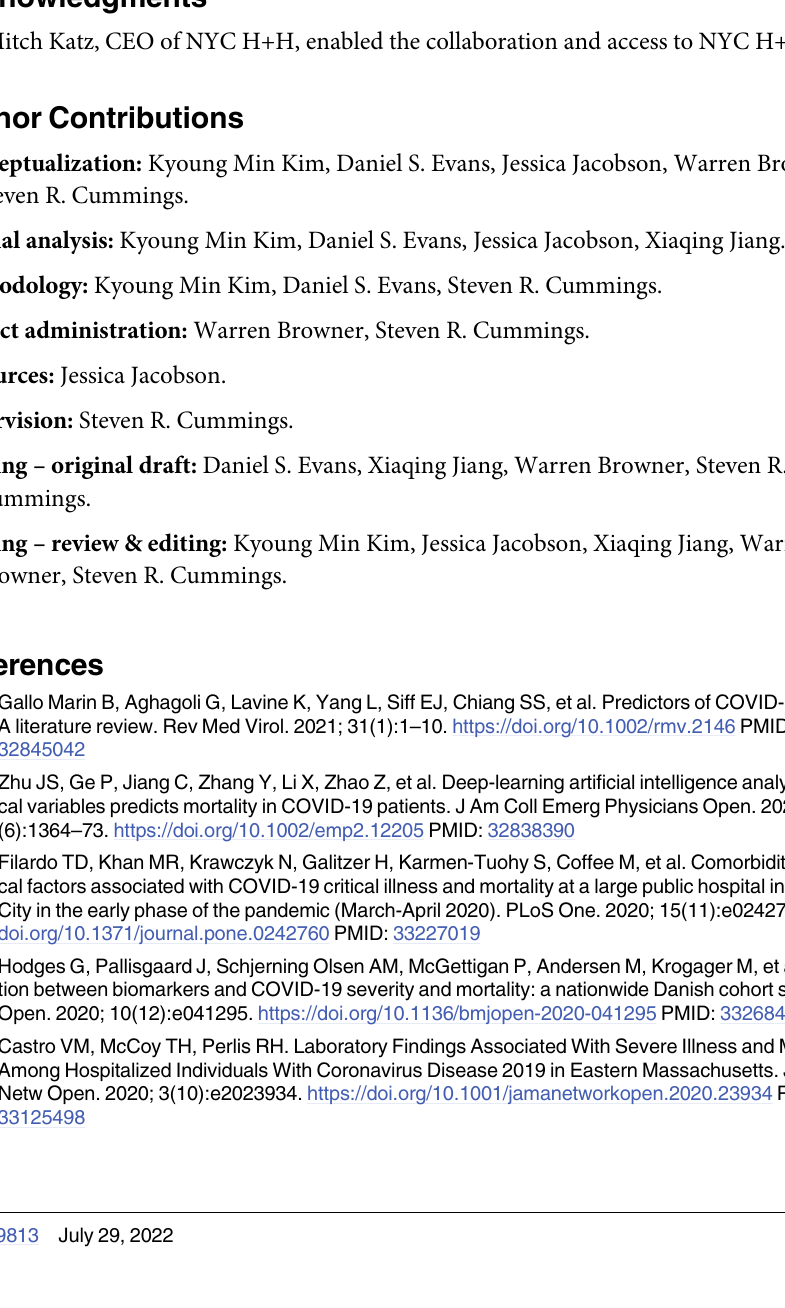
S1 Fig. The sequence of boosted decision trees. The first (top) figure (Tree 0) is the first boosted decision tree from the XGBoost model. The next (Tree 1) is the second boosted deci- sion tree from the XGBoost model. The next tree (Tree 2) is the third boosted decision tree from the XGBoost model. The bottom tree (Tree 3) is the fourth boosted decision tree from the XGBoost